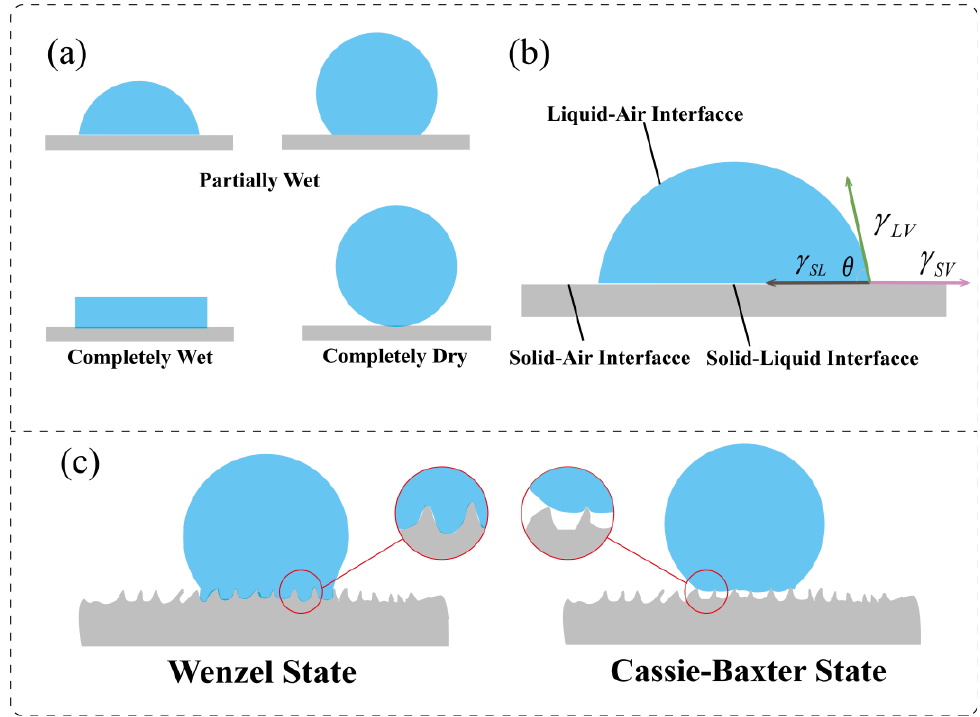
Figure 2. ( a ) Different wetting states of droplets resting on solid substrates. ( b ) Conceptual diagram of three-phase contact angle. ( c ) Two common states of droplets on a topologically patterned surface.